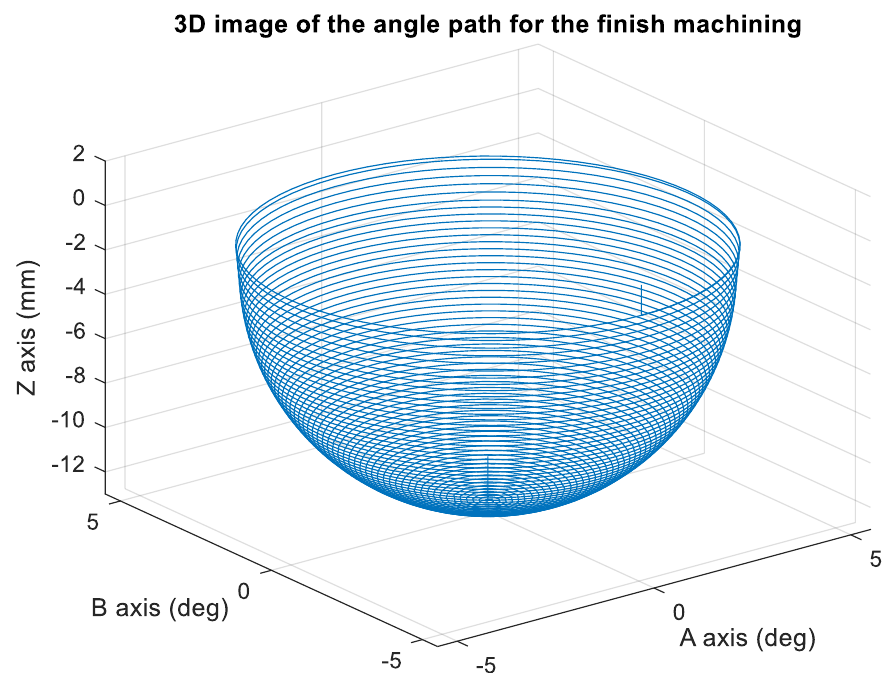
Figure 16. Three-dimensional image of the angle path with Z axis for the original finish machining program.